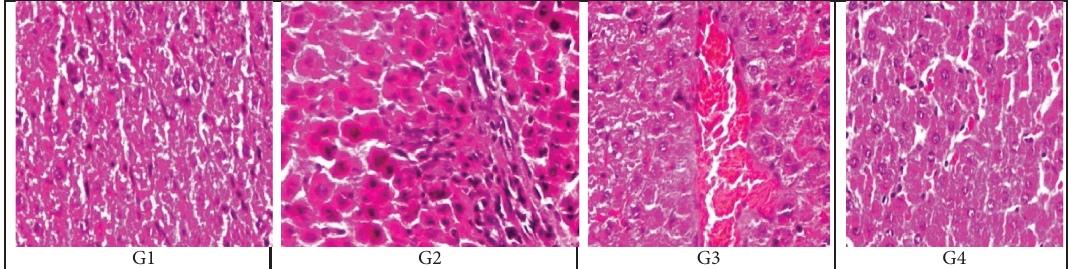
Figure 5: H&E stain showing the histological structure of liver tissue section at 20x magnifcation in the form of (G1) negative control group, (G2) rats infected with MRSA without treatment, (G3) rats treated with antibiotics and (G4) rats treated with A. herb Alba TiO2